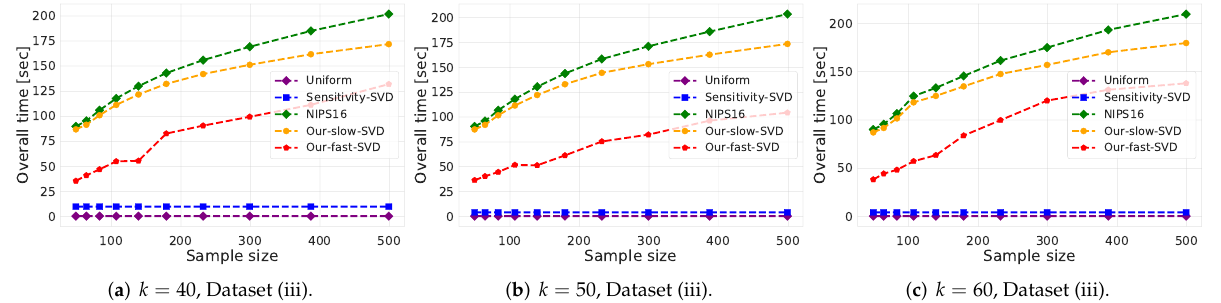
Figure 5. Experimental results for k -SVD, we used Dataset (iii). The x axis is the size of the subset (coreset), while the y axis is the overall time took to compute the coreset and to solve the problem on it. The difference between the 3 graphs is the chosen low dimension k .